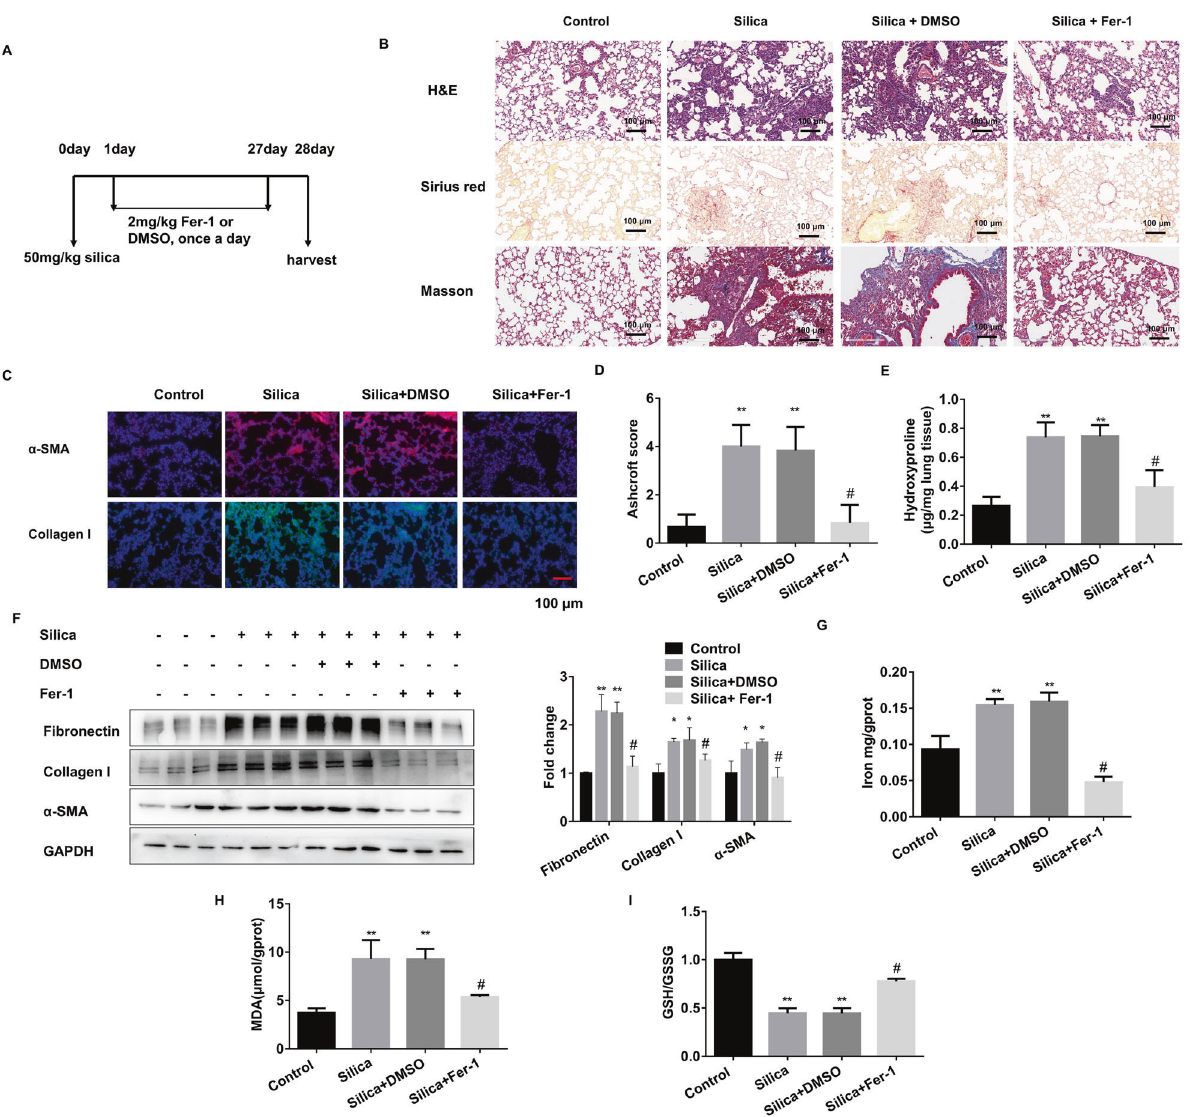
Fig. 1 Ferroptosis inhibitor Fer-1 alleviates silica-induced PF in vivo. A Schematic diagram of Fer-1 or DMSO-treated mouse silicosis model. Mice from control, 50 mg/kg silica, 50 mg/kg silica with 2 mg/kg Fer-1, and 50 mg/kg silica with DMSO-treated groups were sacri fi ced on day 28. B Representative hematoxylin/eosin (HE), Sirius red, and Masson staining of lung tissues from each group were presented (scale bars, 100 µm). C Representative immuno fl uorescence staining of α -SMA and Collagen I from mouse lung tissues (scale bars, 100 µm). D Ashcroft score of mice from each group. E The levels of hydroxyproline content were determined at 550 nm and expressed as micrograms per mg of lung tissues, determined by the hydroxyproline content assay kit. F The protein levels of Fibronectin, Collagen I, and α -SMA in lung tissues from each group were detected by western blot and quali fi ed (means ± SD, n = 3). G The labile iron concentration of lung tissues was assessed using an Iron Colorimetric Assay Kit. H MDA concentration lung tissues was measured using a Lipid Peroxidation MDA Assay Kit. I GSH/GSSG ratio of lung tissues. * P < 0.05, ** P < 0.01 versus control group, # P < 0.01 versus silica + DMSO treated